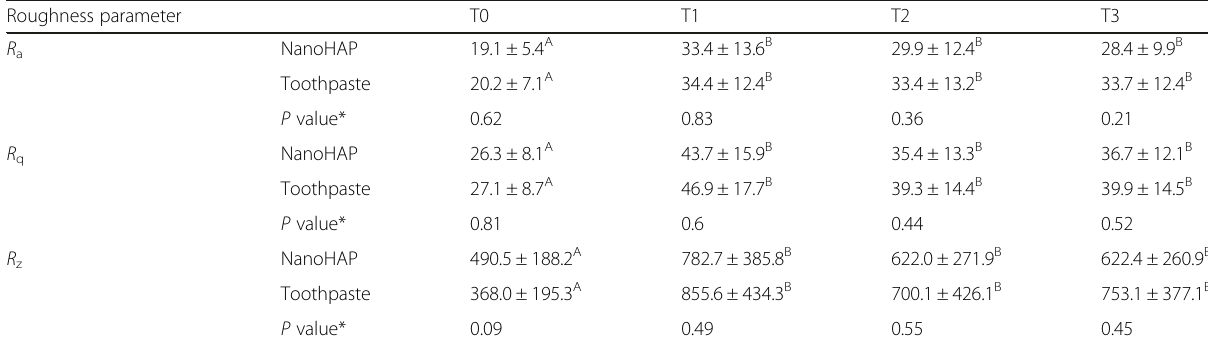
Table 2 Means, standard deviation, and t test results of surface roughness measurements (nm) for the groups Roughness parameter